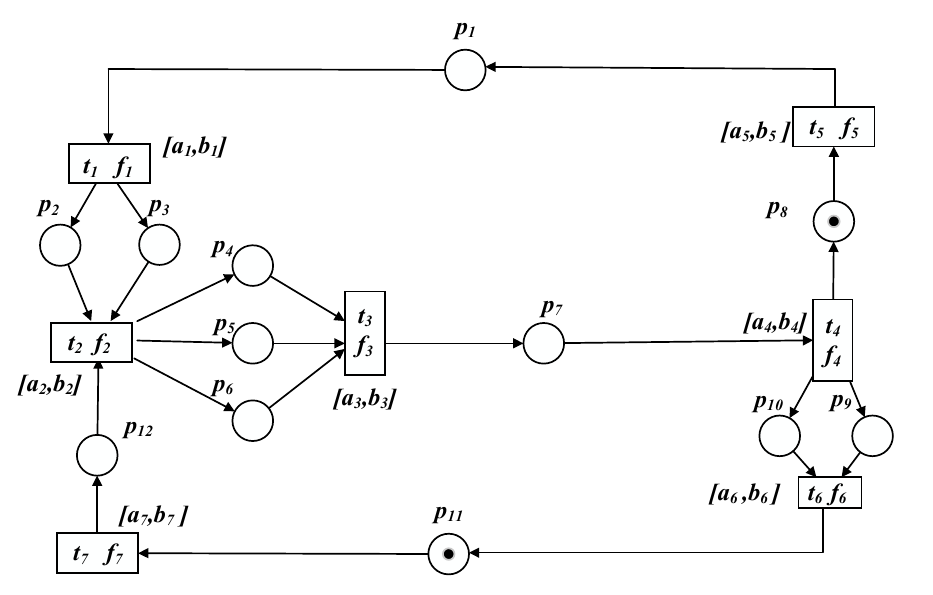
Figure 3. The abstract model 𝑁 .